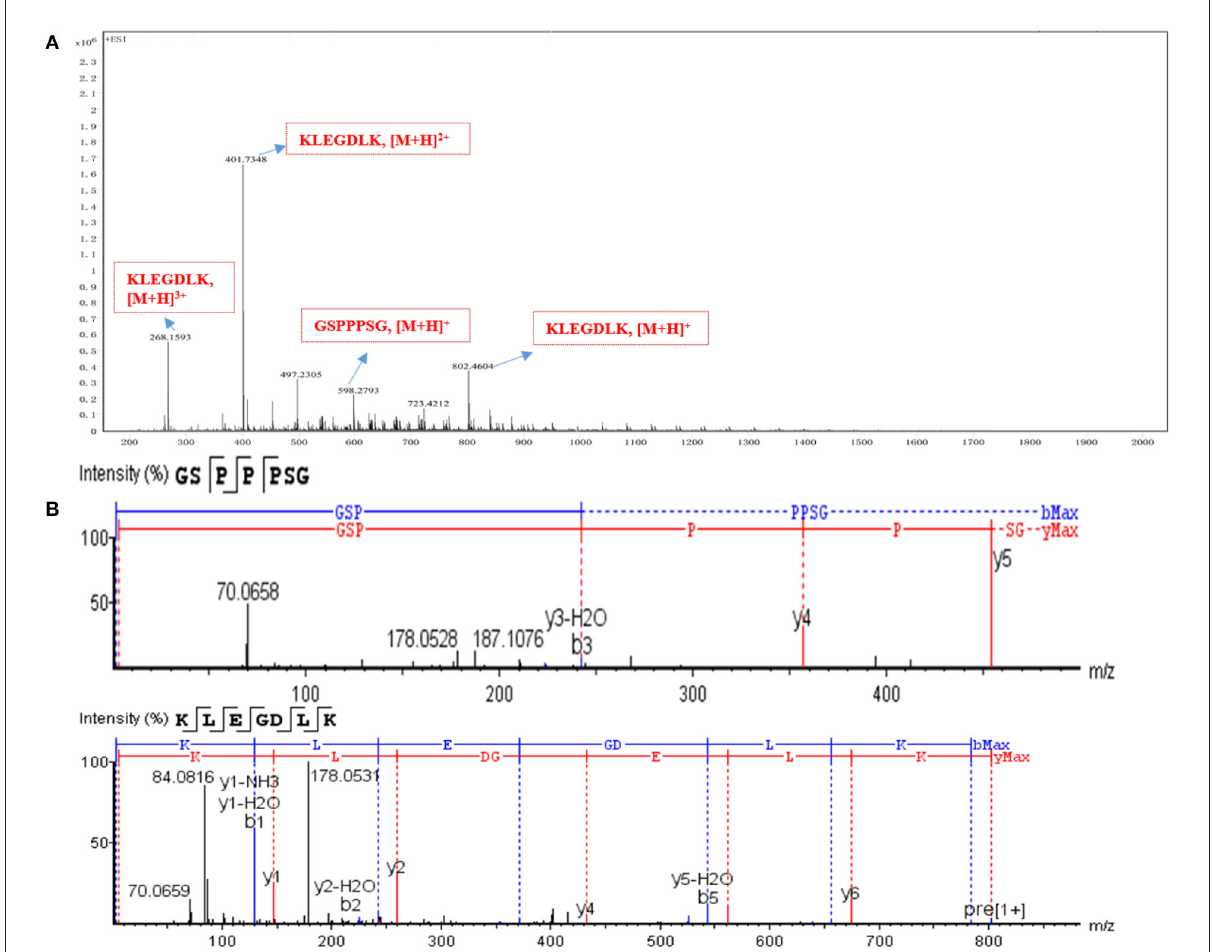
FIGURE3 Identification of active peptides. (A) The HR-ESI-MS of peak 3. (B) the full MS/MS spectrum of GSPPPSG and